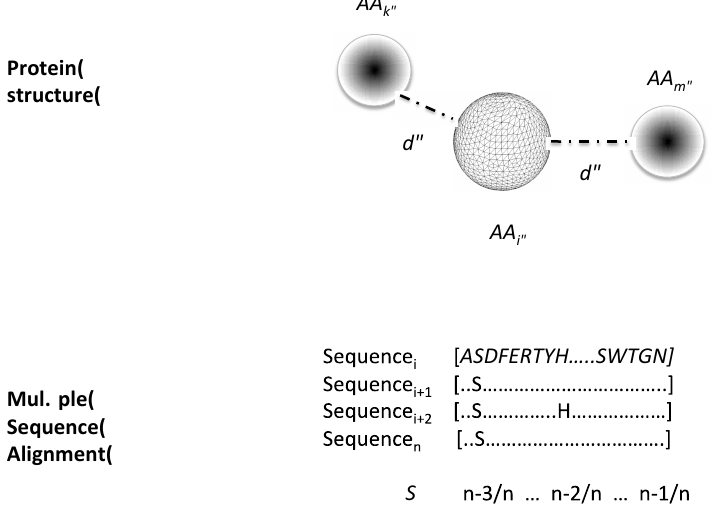
Figure 2. Correlated mutation index of contacting residues. The image represents in the upper part the contacting residues ( AA k and AA m ) for residue AA i in the three-dimensional protein structure; a distance ( d ) criterion of 5 Å defined contacting residues (see Materials and Methods). In the lower part, the substitution rate ( S ) is derived from a structure-based multiple sequence alignment for each of the residues in contact; the bottom part of the image shows an example on how to obtain the S parameter (for a more detailed description, please read the corresponding Methods section). Each residue in a sequence is represented by a one-letter code; only conserved residues are shown in the alignment, the rest of the sequence is presented as dots.